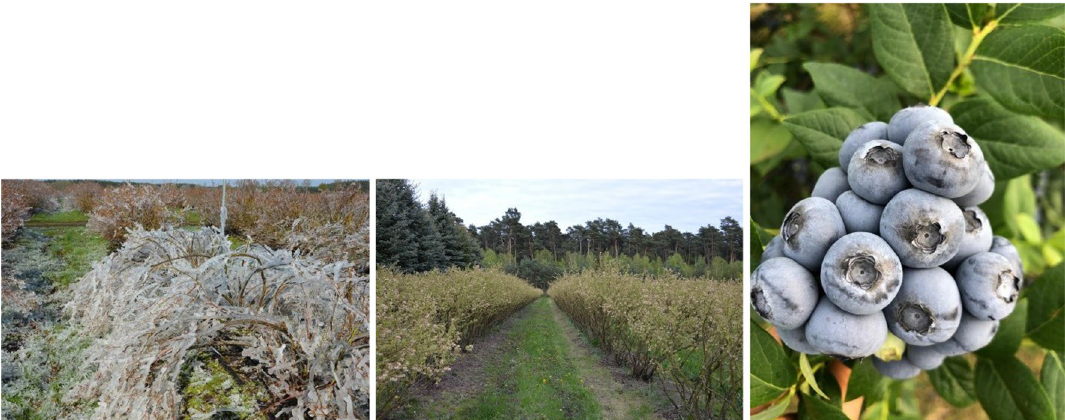
Figure 2. Protection of bushes against frost, organic plantation and highbush blueberry fruit (phot. I.